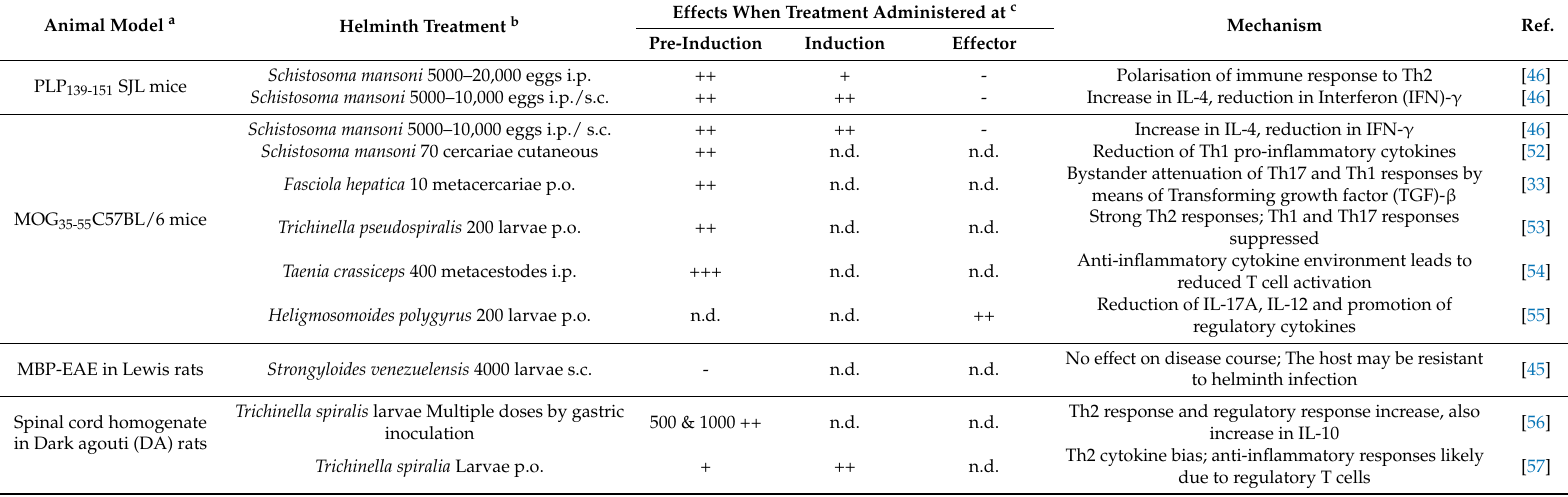
Table 1. Studies reporting live helminth infection in animal models of Experimental Autoimmune